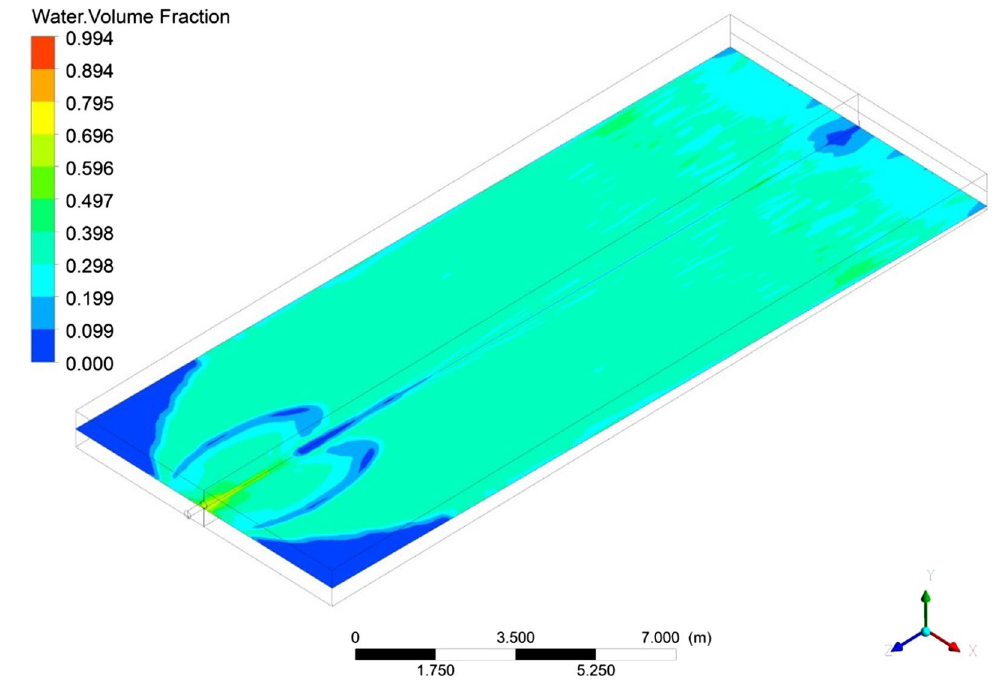
Fig. 16 Volume percentage of water at 386.415